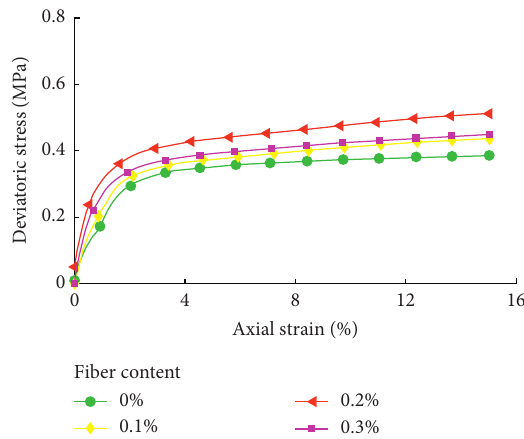
Figure 8: Deviatoric stress-axial strain for fiber-reinforced soil with different fiber contents (confining pressure � 0.1 MPa; com- paction degree �